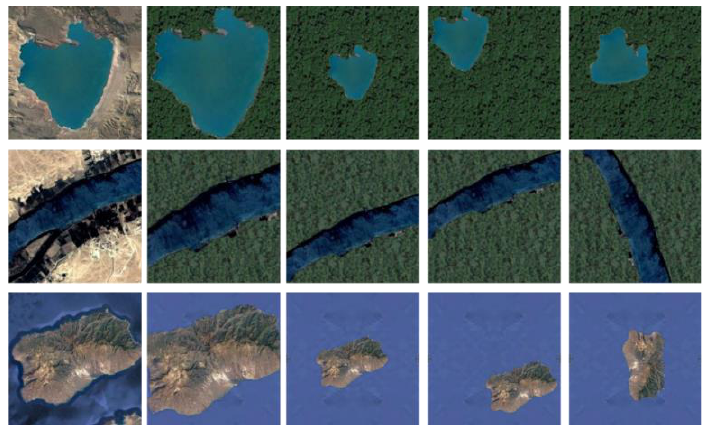
Figure 5. Results of geometric transformation on elements of lake, river, and island.